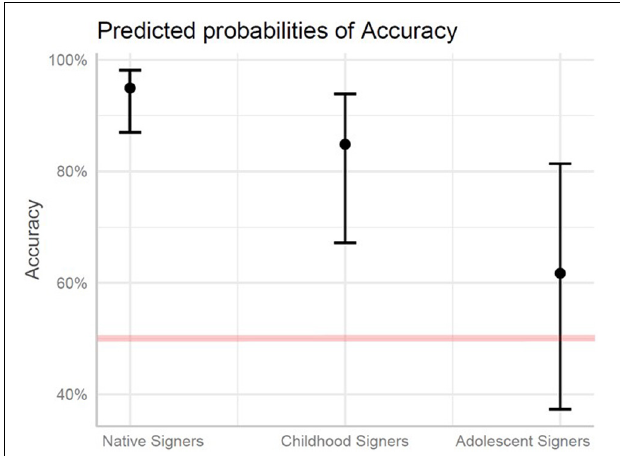
FIGURE 2 | Predicted probabilities of accuracy for native signers, childhood signers, and adolescent signers for phonology. The red line denotes chance responding (50%).